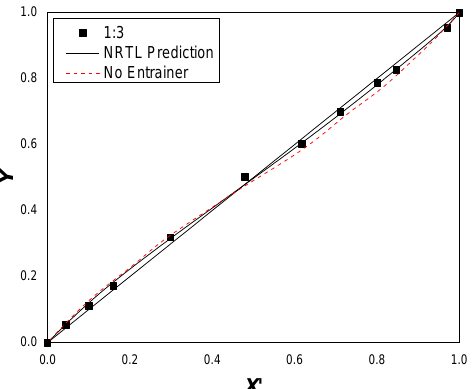
Figure 7. Experimental and calculated data X’Y diagram for cyclohexane (1) + benzene (2) + DES(1:3) (3) at constant pressure (101.325 kPa) and constant DES molar fraction ( X 3 = 0.1).